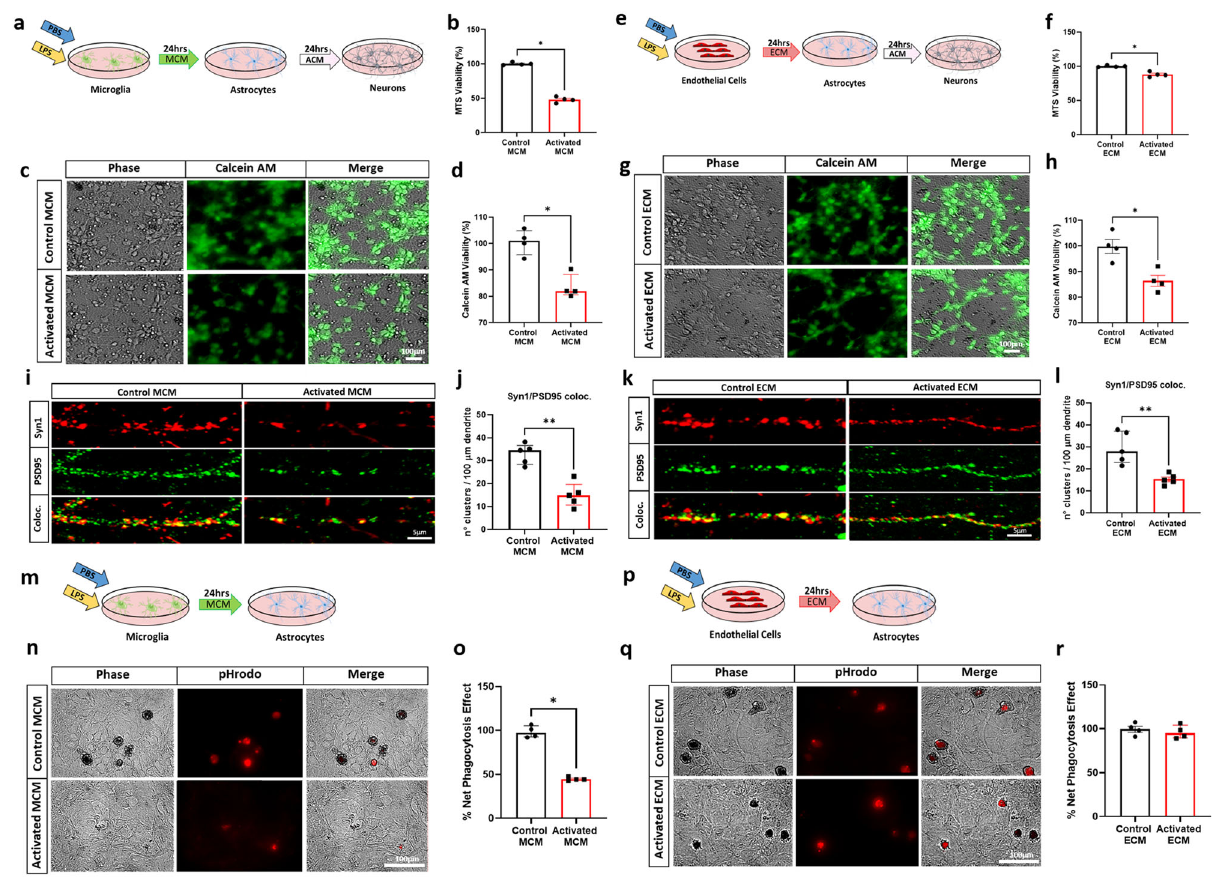
Fig. 2 Astrocytes induced by activated ECM are neurotoxic and retain phagocytic capacity. a Schematic diagram showing ACM treatment of neurons from previously treated control or activated MCM. b Quanti fi cation of MTS Viability assay c ) Phase and fl uorescence images of Calcein AM in cultured neurons (quanti fi cation in d ). e Schematic diagram showing ACM treatment of neurons from previously treated control or activated ECM. f Quanti fi cation of MTS Viability assay g Phase and fl uorescence images of Calcein AM in cultured neurons (quanti fi cation in h ). i Representative immuno fl uorescence photographs of clusters of the synaptic proteins Synapsin-1 (red), PSD95 (green), and their colocalization (yellow) following ACM treatment of neurons previously treated with control or activated MCM. j Graphs showing the quanti fi cation of positive clusters for the colocalization of Synapsin-1 and PSD95 per 100 μ m of dendrite. k Representative immuno fl uorescence photographs of clusters of the synaptic proteins Synapsin-1 (red), PSD95 (green), and their colocalization (yellow) in ACM treatment of neurons from previously treated control or activated ECM. l Graphs showing the quanti fi cation of positive clusters for colocalization of Synapsin-1 and PSD95 per 100 μ m of dendrite. Images were collected from a single dendrite per neuron and the number of dendrites analyzed was 10 per culture from 5 independent cultures. m Schematic diagram showing treatment of astrocytes with control or activated MCM. n Phase and fl uorescence images of cultured astrocytes engul fi ng pHrodo-zymogen bioparticles (quanti fi cation in o ). p Schematic diagram showing treatment of astrocytes with control or activated ECM q Phase and fl uorescence images of cultured astrocytes engul fi ng pHrodo-zymogen bioparticles (quanti fi cation in r ). The results are shown as the median ± IQR of n = (cid:1) 4. Asterisks indicate signi fi cant differences, where * P < 0.05, **p < 0.01 by Mann-Whitney test. Scale bar 5 μ m or 100 μ m